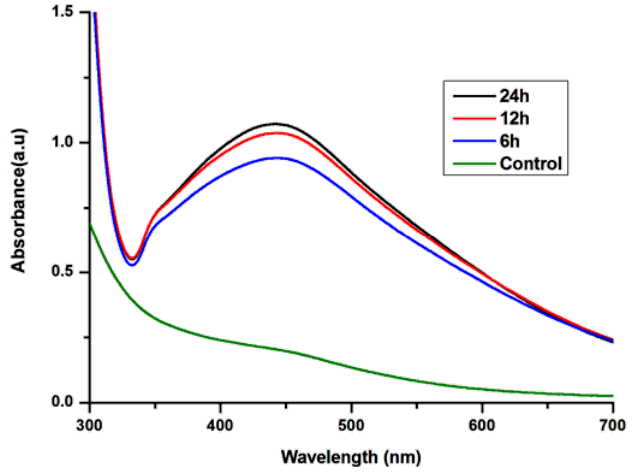
Figure 2. The UV-Vis spectra recorded for the reaction of fungal cell filtrate with AgNO 3